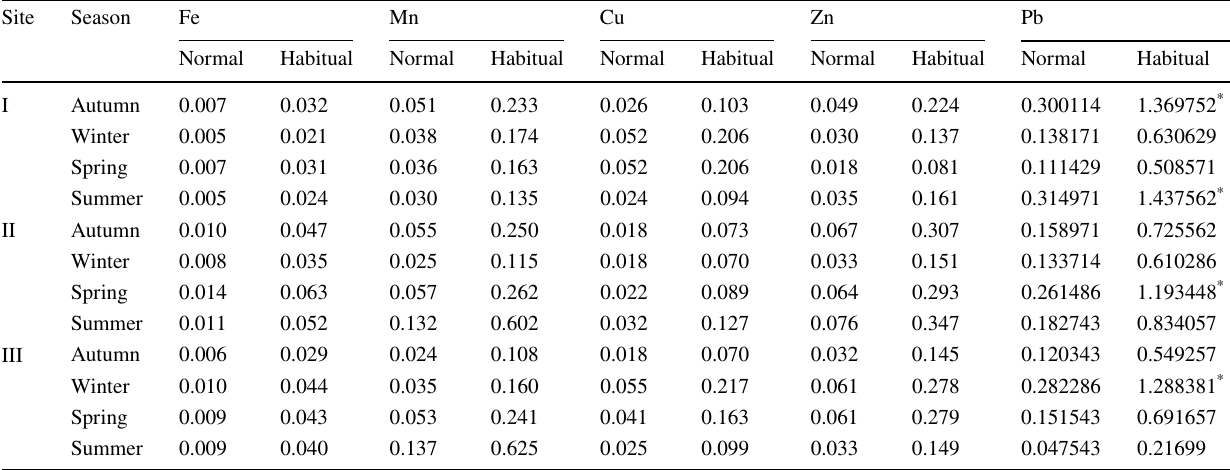
Table 5 Hazard index for muscle of O. niloticus at mean ingestion rate (0.0312 kg/day) and subsistence ingestion rate (0.1424 kg/day)